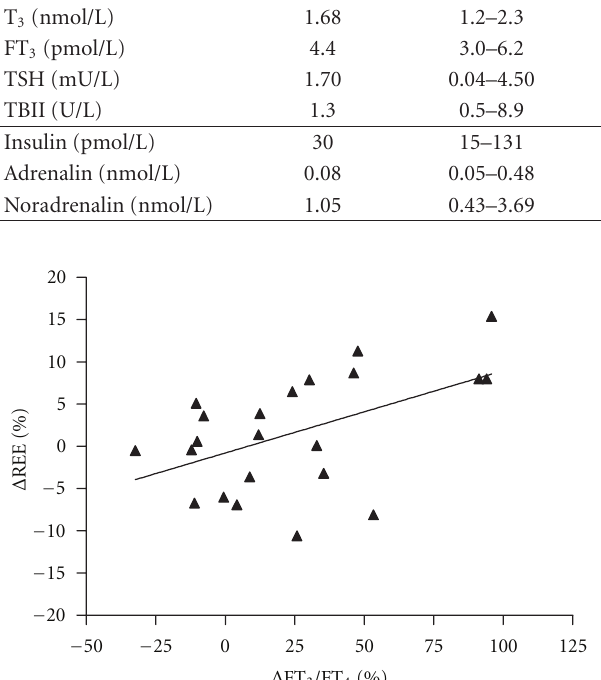
Figure 3: Correlation of the di ff erence in REE corrected for BW between visit 1 and visit 2 ( Δ REE (%)) and the di ff erence in serum FT 3 /FT 4 ratios between visit 1 and visit 2 ( Δ FT 3 /FT 4 (%)). Spearman’s correlation coe ffi cient ( r ) = 0 . 465, P = 0 .